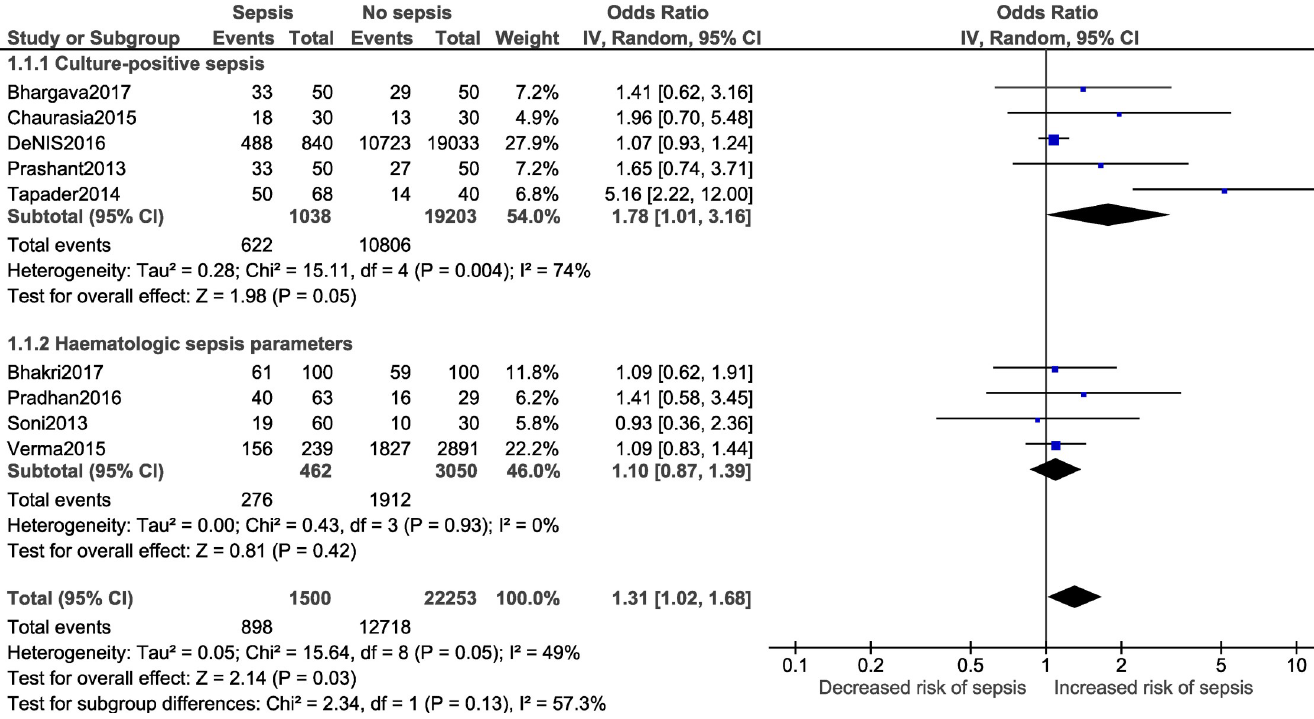
Fig 12. Forest plot showing random-effects meta-analysis for male neonates with and without sepsis sub-grouped by sepsis diagnostic criteria (9 studies) [IV: Inverse Variance; CI: Confidence Interval].